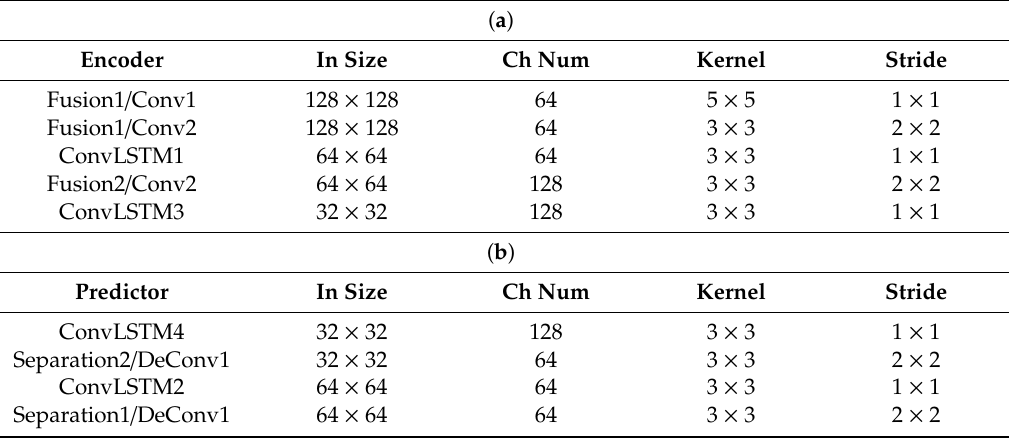
Table 1. The ‘In Size’, ‘Ch Num’, ‘Kernel’ and ‘stride’ are each layer’s input size, number of channels, convolution (deconvolution) kernel size and convolution (deconvolution) stride, respectively. ( a ) The parameters configuration of the encoder; ( b ) The parameters configuration of the predictor. ( a ) Encoder In Size Ch Num Kernel Stride Fusion1 / Conv1 128 × 128 64 5 × 5 1 × 1 Fusion1 / Conv2 128 × 128 64 3 × 3 2 × 2 ConvLSTM1 64 × 64 64 3 × 3 1 × 1 Fusion2 / Conv2 64 × 64 128 3 × 3 2 × 2 ConvLSTM3 32 × 32 128 3 × 3 1 × 1 ( b ) Predictor In Size Ch Num Kernel Stride ConvLSTM4 32 × 32 128 3 × 3 1 × 1 Separation2 / DeConv1 32 × 32 64 3 × 3 2 × 2 ConvLSTM2 64 × 64 64 3 × 3 1 × 1 Separation1 / DeConv1 64 × 64 64 3 × 3 2 ×